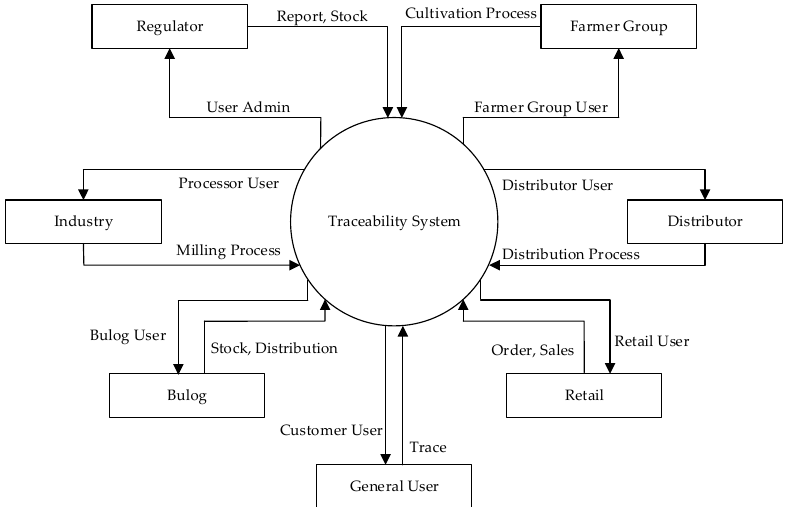
Figure 4. Context diagram of the traceability system. Data flow diagram (DFD) level 0.